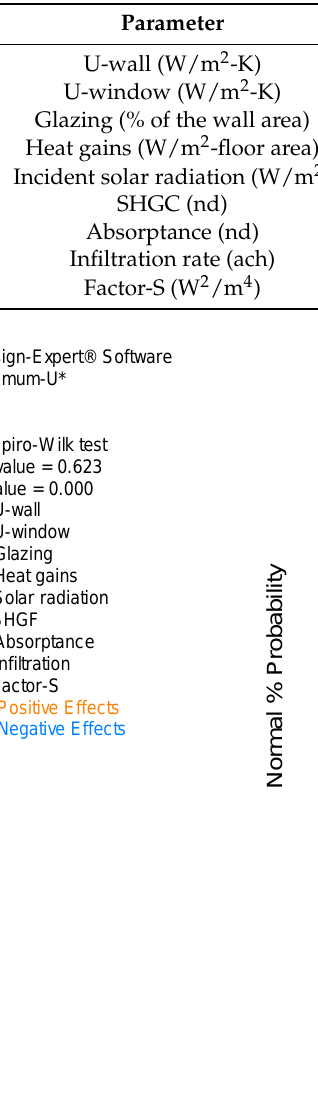
Figure 10. Revealing the most significant parameters affecting optimum thermal transmittance.